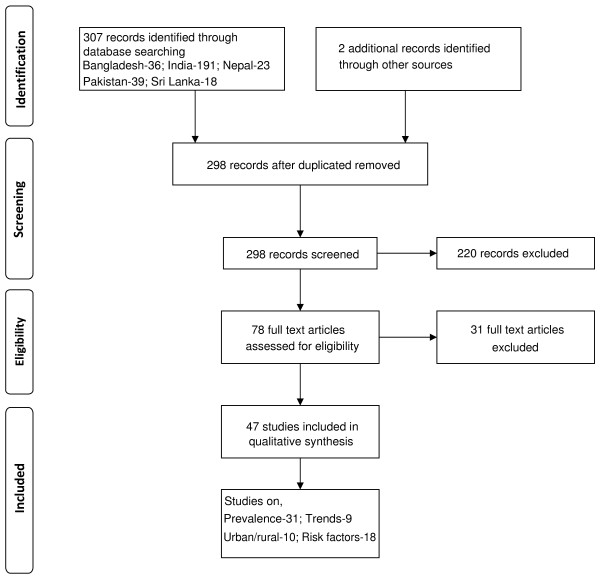
Summarized search protocol.